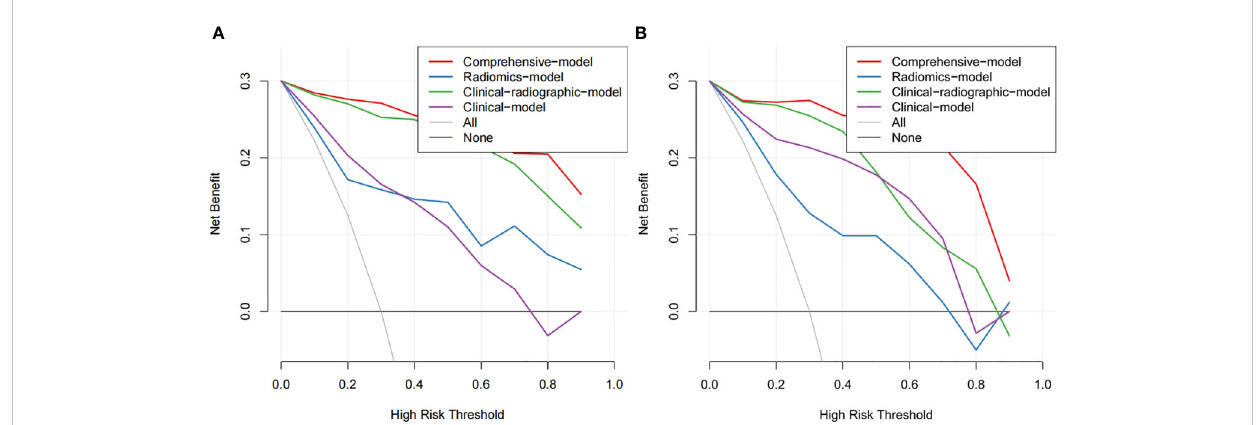
FIGURE 6 The DCA of the developed nomogram in training cohort (A) and validation cohort (B) . The y-axis and x-axis represent the net bene fi t and threshold probability, respectively. At the bottom, the black line “ None ” represented the assumption that none developed PSCLC, while the gray line “ All ” represented the assumption that all patients suffered PSCLC. The red line represented the net return of using the nomogram to predict